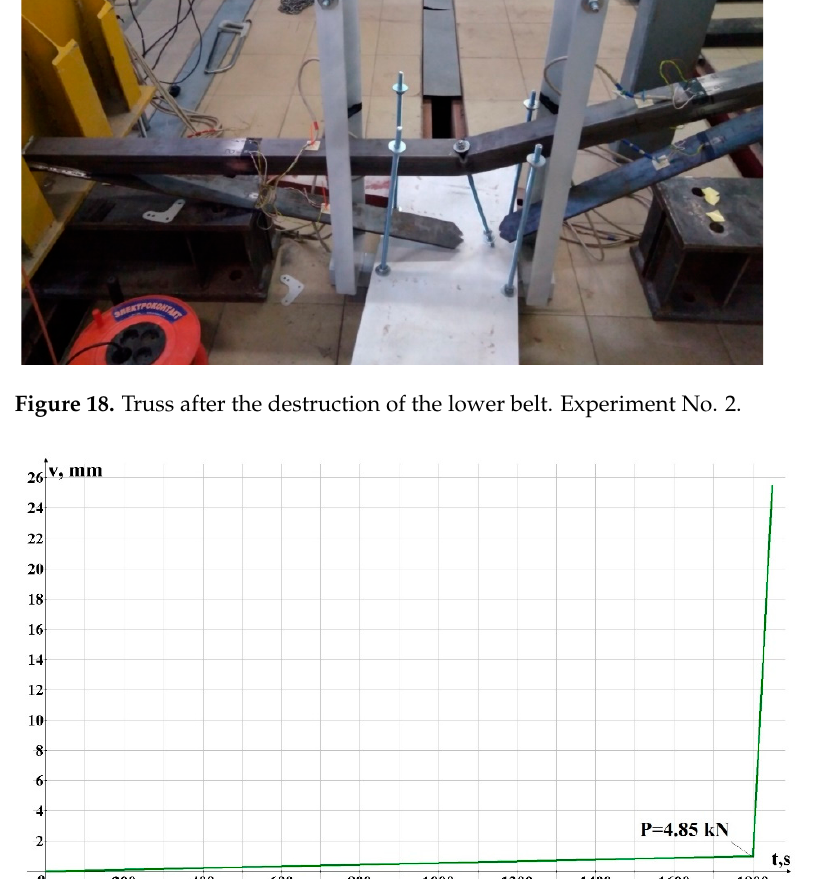
Figure 19. Change in the deflection of the truss, mm ( y -axis) in time, s ( x -axis). Experiment No. 2.